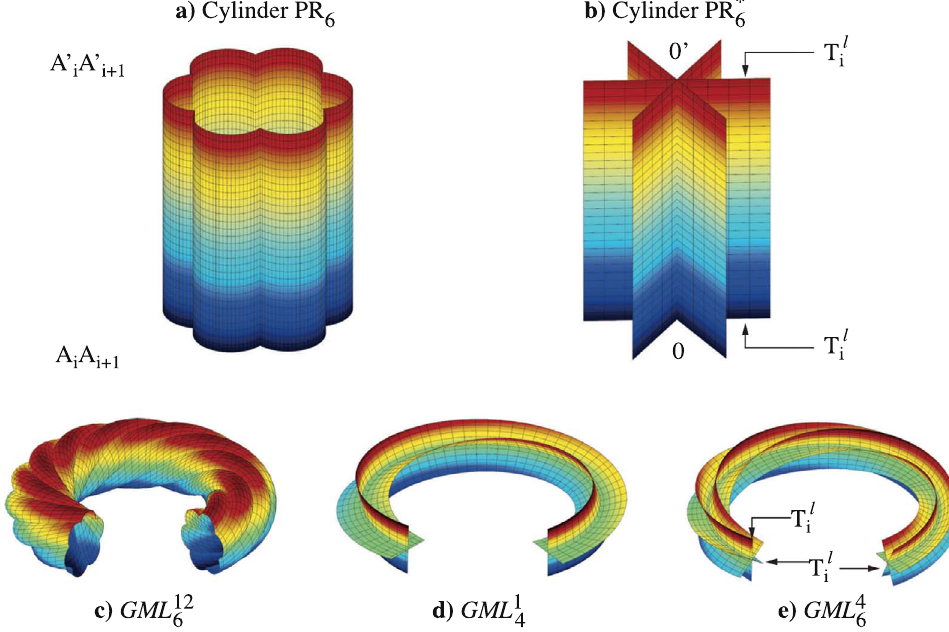
Figure 1. Identi fi cation of vertices of prisms (a) PR 6 and (b)PR (cid:5) number of twists relative to the symmetry of the cross sections is indicated by the